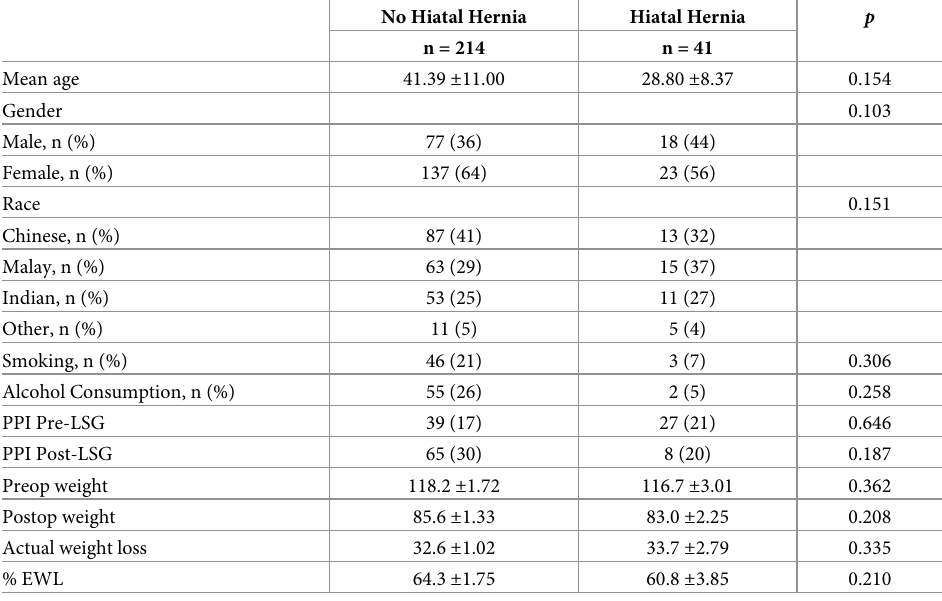
Table 1. Patient’s baseline characteristics.